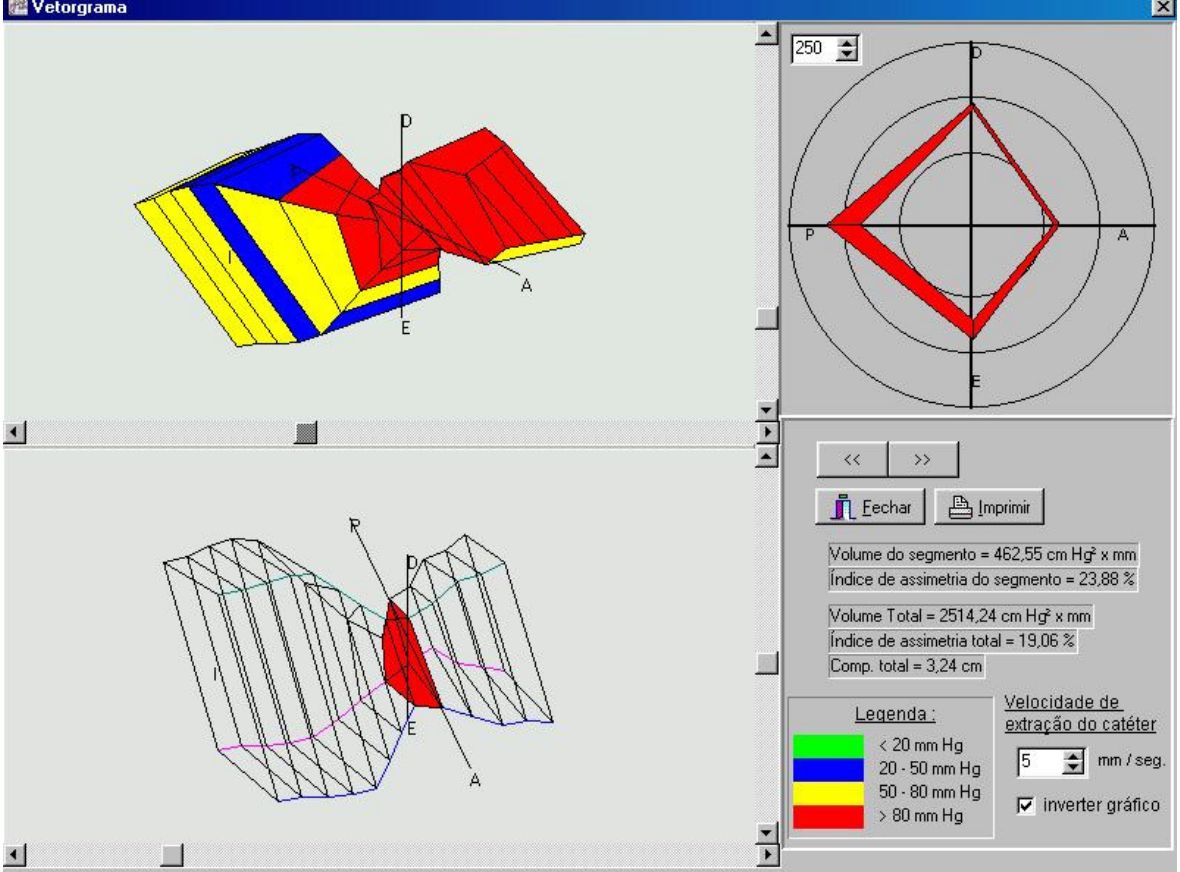
FIGURE 2 – Postoperative profilometry (vectorgram). Patient underwent to